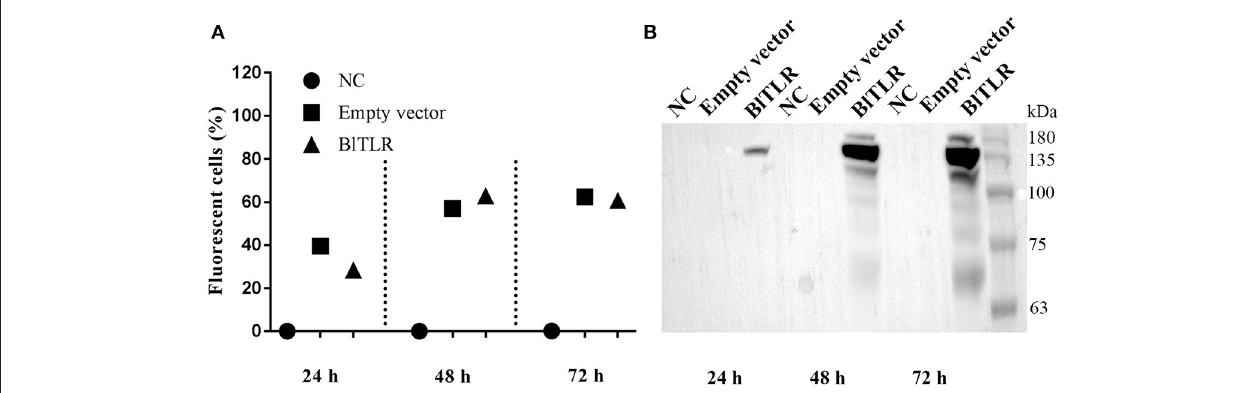
FIGURE 4 | BlTLR expression in HEK293 cells. (A) HEK293 cells transfected with an empty vector (pIRES2-EGFP) and a vector expressing BlTLR were analyzed at 24, 48 and 72h post-transfection by flow cytometry. Non-transfected cells (NC) were used as a control. Transfection efficiency was evaluated as the percentage of GFP positive cells. (B) Non-transfected cells, cells transfected with the empty vector and the vector expressing BlTLR with HA tag were analyzed at 24, 48 and 72h post-transfection by western blot. Protein molecular weight standards (Niborlab) are shown on the right side.